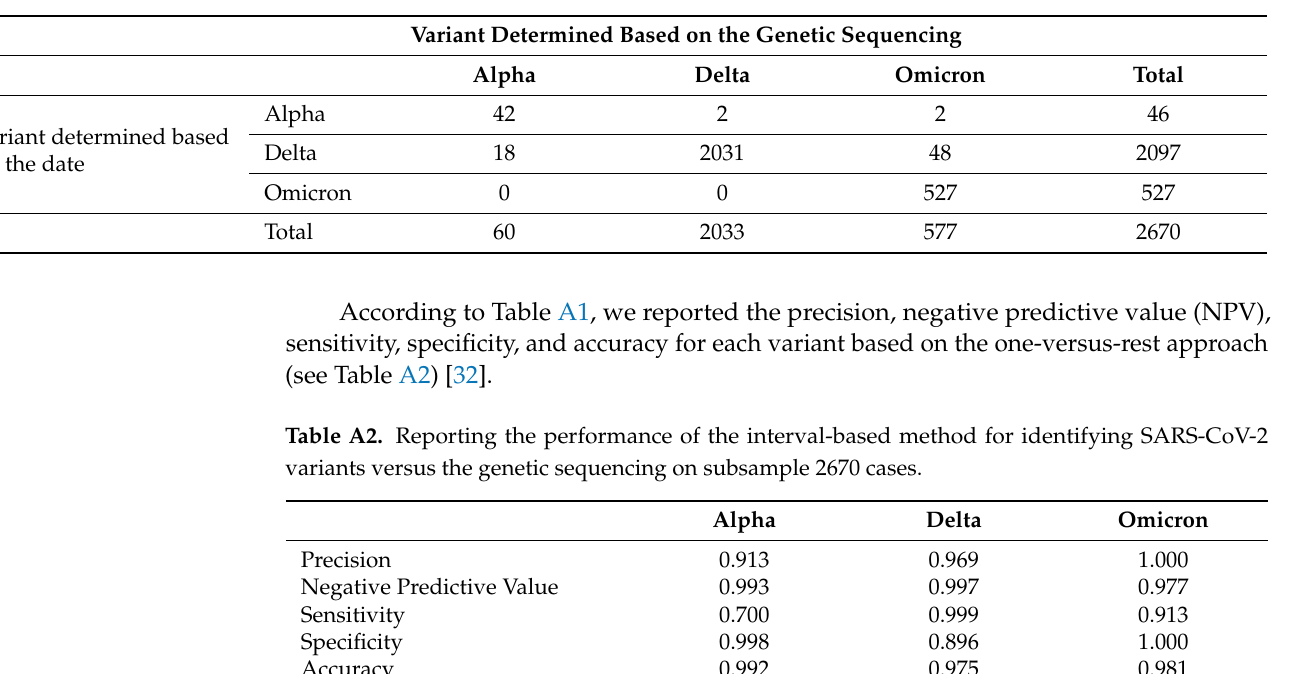
Table A1. Reporting the number of cases grouped into three SARS-CoV-2 variants based on the genetic sequencing versus the date.